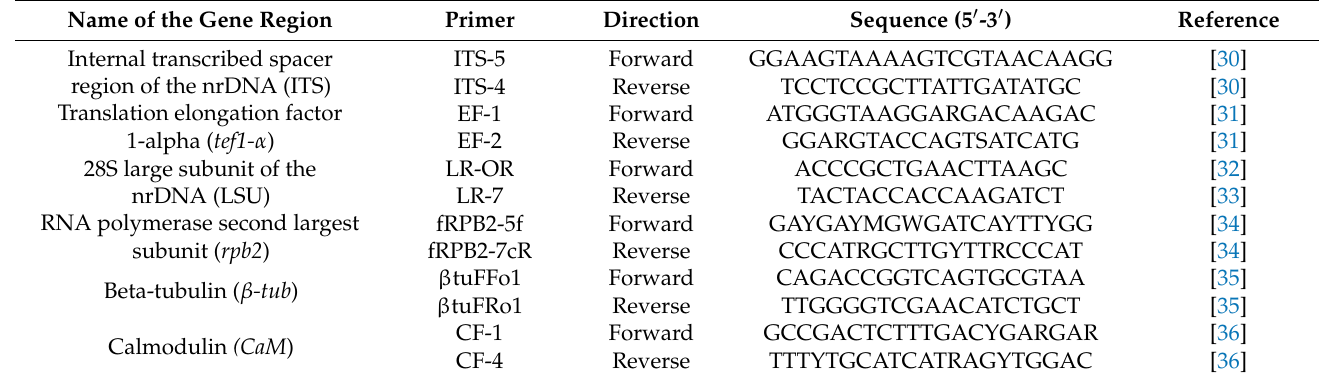
Table 3. PCR primer sets used in this study for amplification as well as